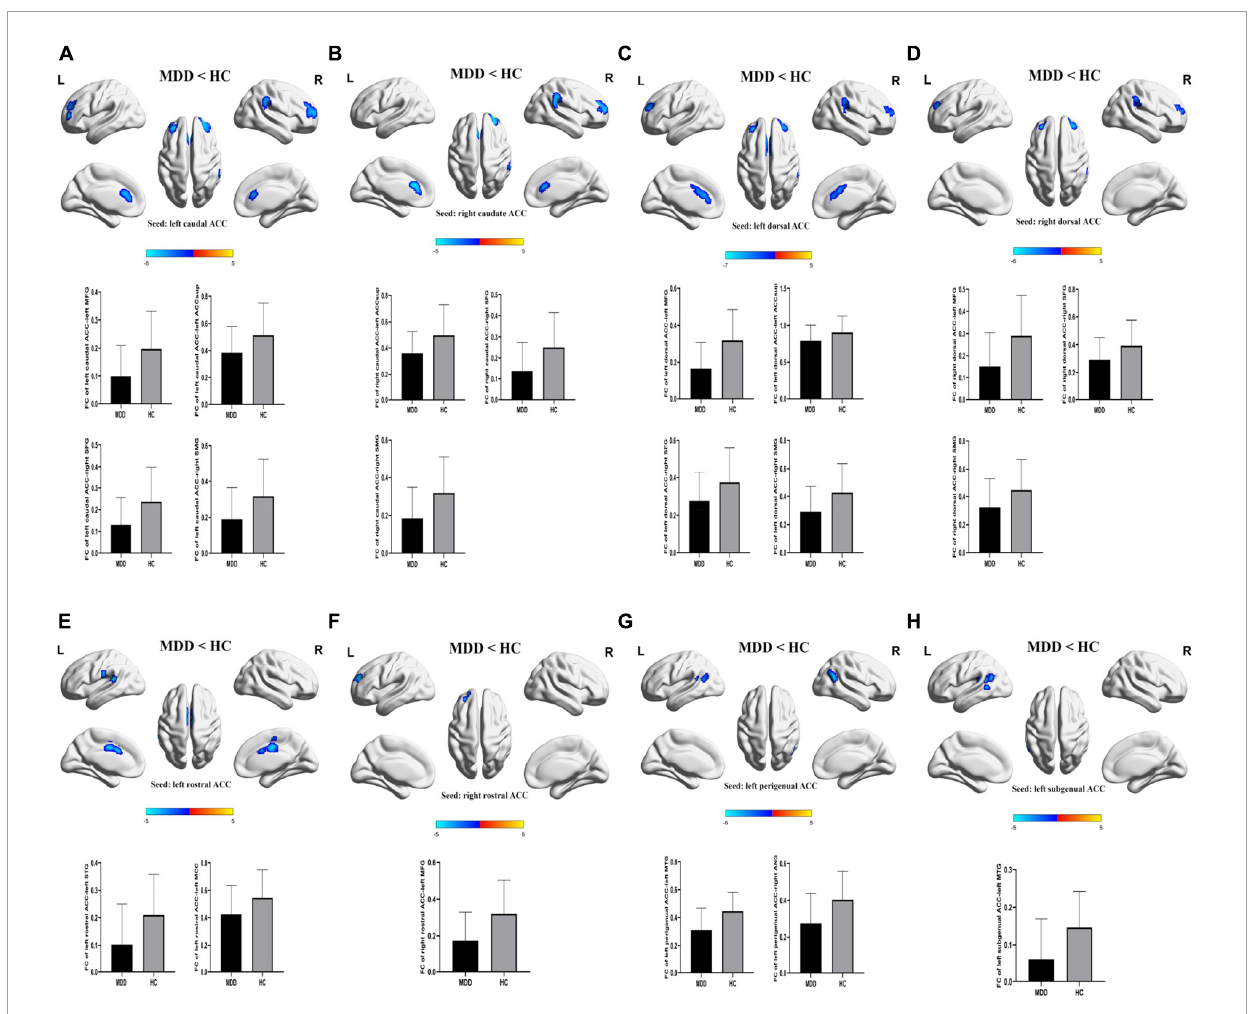
FIGURE3 The significant main effect of diagnosis on FCs of ACC subregions. (A–H) MDD patients had decreased rsFCs of bilateral caudal ACC, bilateral dorsal ACC, bilateral rostral ACC, left perigenual ACC and left subgenual ACC compared to HC. Significance threshold was set at p < 0.001 at voxel level uncorrected, p < 0.05 at cluster level, with Gaussian random field correction (GRF). L, left; R, right; MDD, major depressive disorder; HC, healthy controls; FC, functional connectivity; CT, childhood trauma; ACC, anterior cingulate cortex; MFG, middle frontal gyrus; SFG, superior frontal gyrus; SMG, supra marginal gyrus; STG, superior temporal gyrus; MTG, middle temporal gyrus; ANG, angular gyrus. ACCsup, anterior cingulate cortex, supracallosal; MCC, middle cingulate & paracingulate